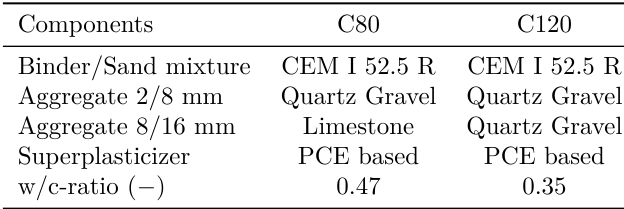
Table 1. Concrete compositions of C80 and C120.